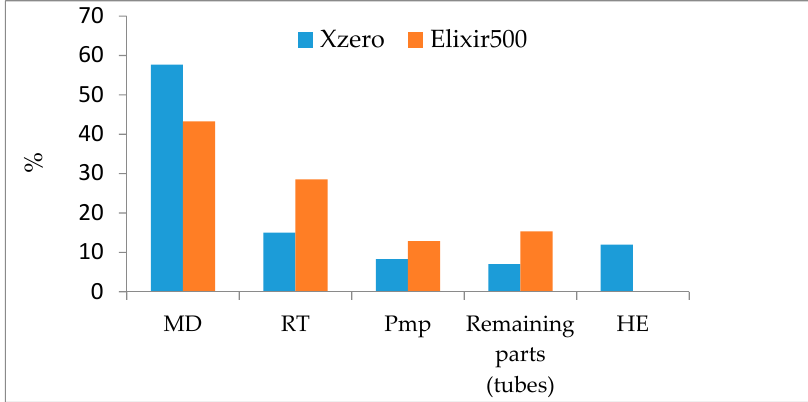
Figure 8. Percentage contribution of exergy destruction from the different components of each AGMD system.